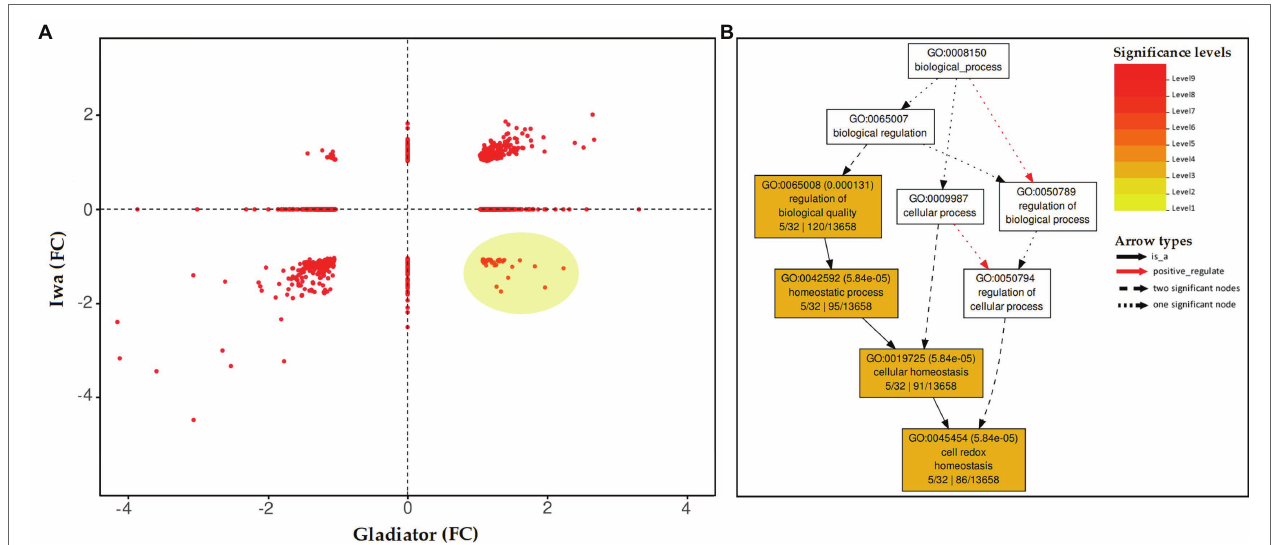
FIGURE 4 | (A) Distribution of the differentially abundant leaf proteins (inoculated vs. non-inoculated) common to both potato cultivars (Gladiator and Iwa). The changes in proteins were presented as fold changes (FC). Distribution of the differentially abundant proteins (DAPs) in common between Gladiator and Iwa. The changes in proteins were presented as fold changes. (B) Enrichment analysis (BP) for the proteins that increased in leaves of cultivar Gladiator but decreased in cultivar Iwa 6 weeks post-inoculation.